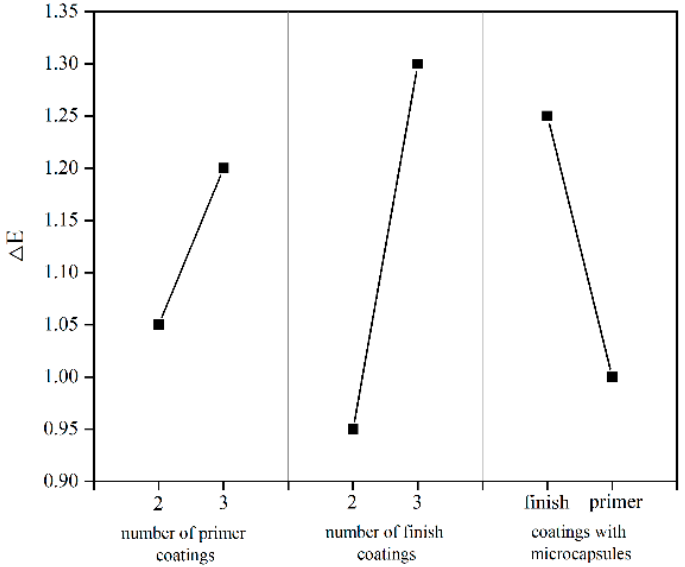
Figure 3. Main effects plot of number of primer coatings, number of finish coatings, and coatings with microcapsules. Table 4. Influence of coating processes on gloss of water-based coating containing